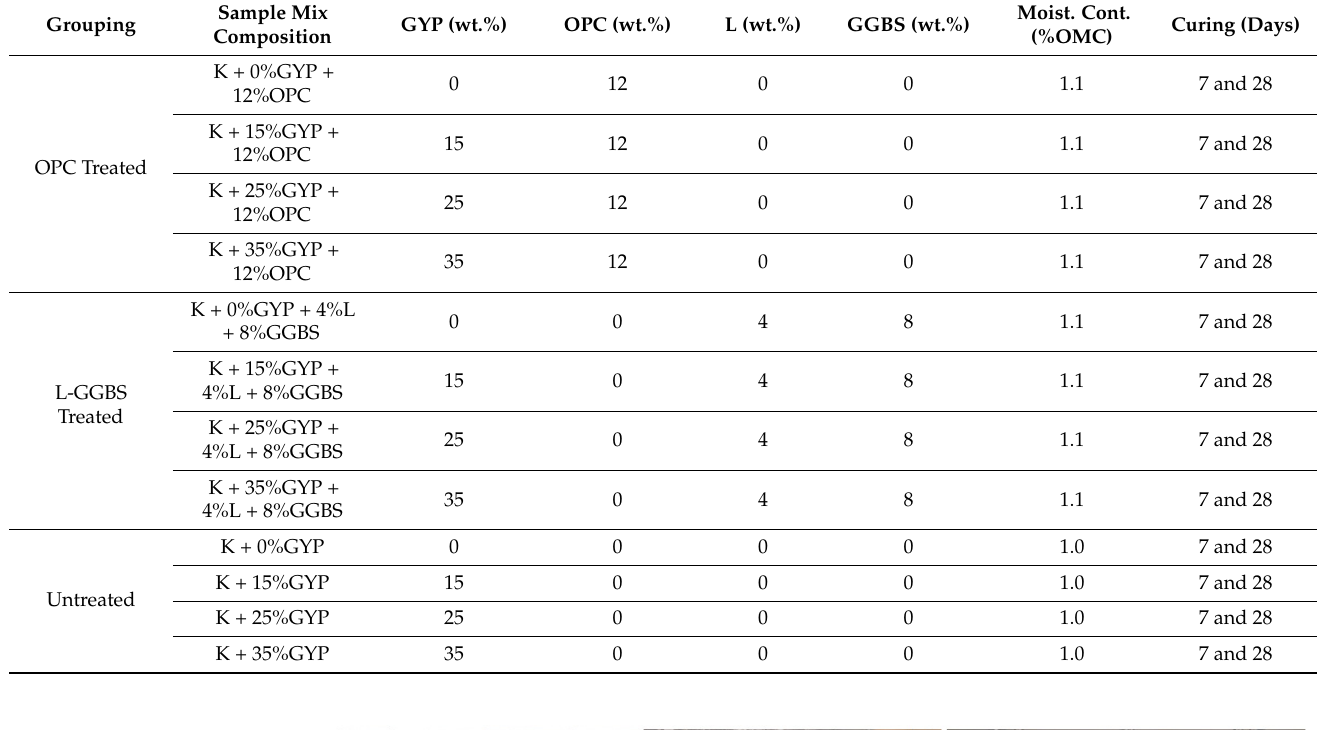
Table 4. Sample mix compositions.